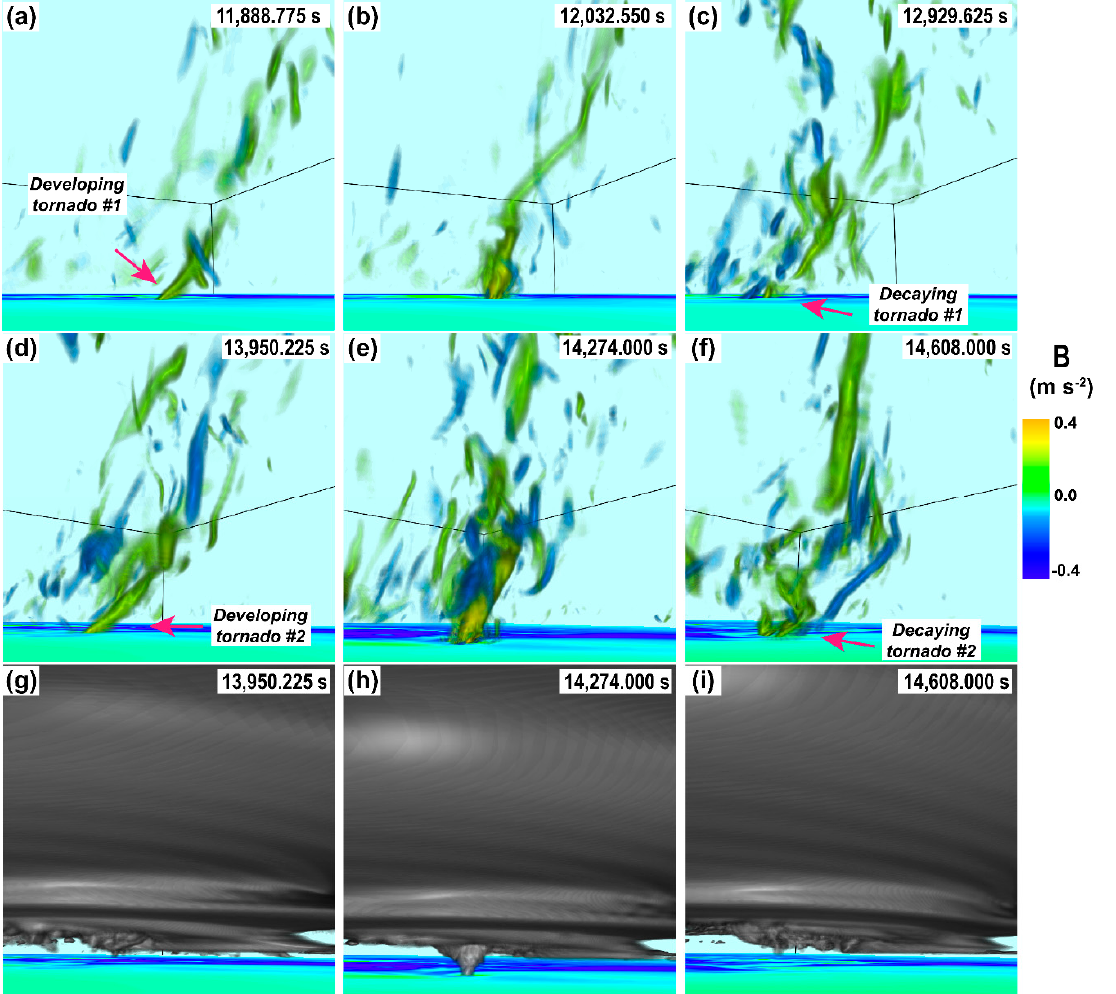
Figure 3. ( a )–( f ) DVR of vertical vorticity with values greater (less) than 0.075 s − 1 ( − 0.075 s − 1 ) indicating regions of cyclonic (anticyclonic) rotation in yellow (blue). Buoyancy (B; in m s − 1 ) is displayed at 1 m AGL, with positively or neutrally (negatively) buoyant air in green (blue). The life cycle of the first tornado is shown at ( a ) 11,888.775 s (tornadogenesis), ( b ) 12,032.550 s (peak stage), and ( c ) 12,929.625 s (demise). ( d )–( f ) Same as in ( a )–( c ), but for the second tornado at ( d ) 13,950.225 s, ( e ) 14,274.000 s, and ( f ) 14,608.000 s. ( g )–( i ) The cloud field (sum of cloud water and cloud ice mixing ratios; in g kg − 1 ) corresponding to the second tornado in ( d )–( f ). All nonzero values are displayed.